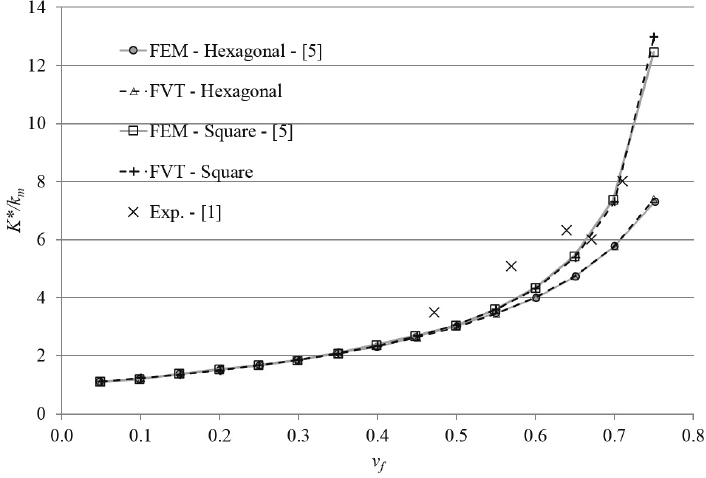
Figure 9. Variation of the normalized effective transverse thermal conductivity of the composite in function of the fiber volume fraction.